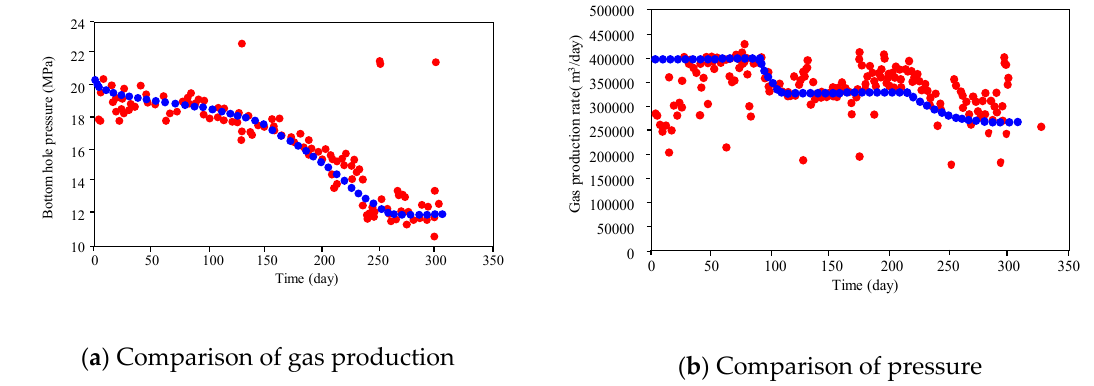
Figure 5. Comparison of the calculated data and observed well data. Table 1. Basic parameters in numerical simulation.